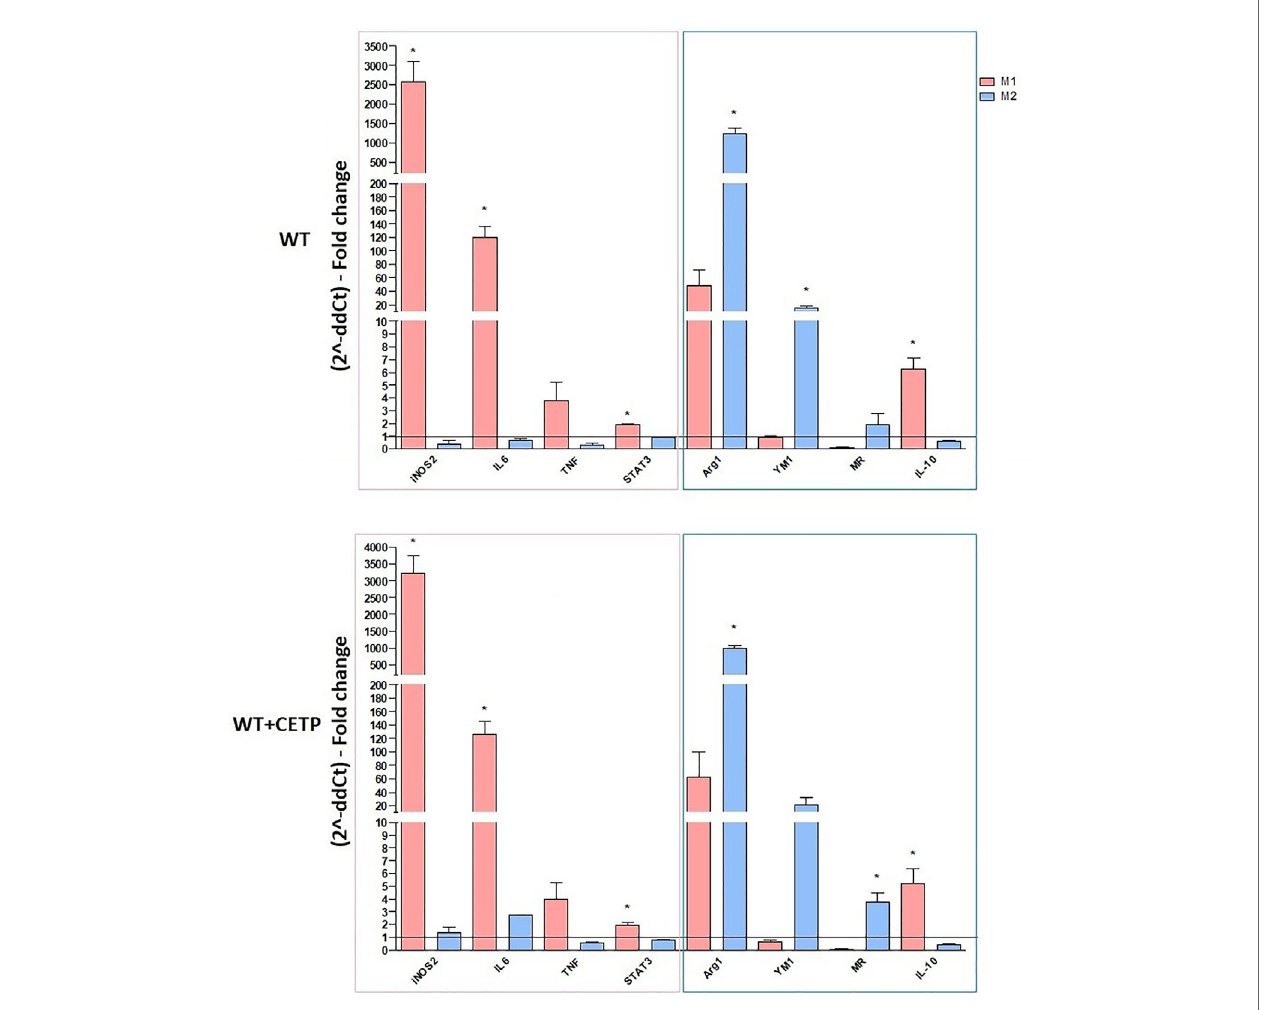
FIGURE 6 | Gene expression of typical M1 and M2 markers in bone marrow-derived macrophages from WT mice stimulated in the presence of recombinant CETP in vitro . Macrophages were stimulated using 5 ng/ml IFN g + 50 ng/ml LPS (M1) or 10 ng/ml IL-13 + IL-4 (M2) for 24 h. mRNA expression was determined by RT-PCR. Results are expressed as the mean ± standard deviation and compared by unpaired Student ’ s t-test. (n = 3 – 5). *P < 0.05 for 24